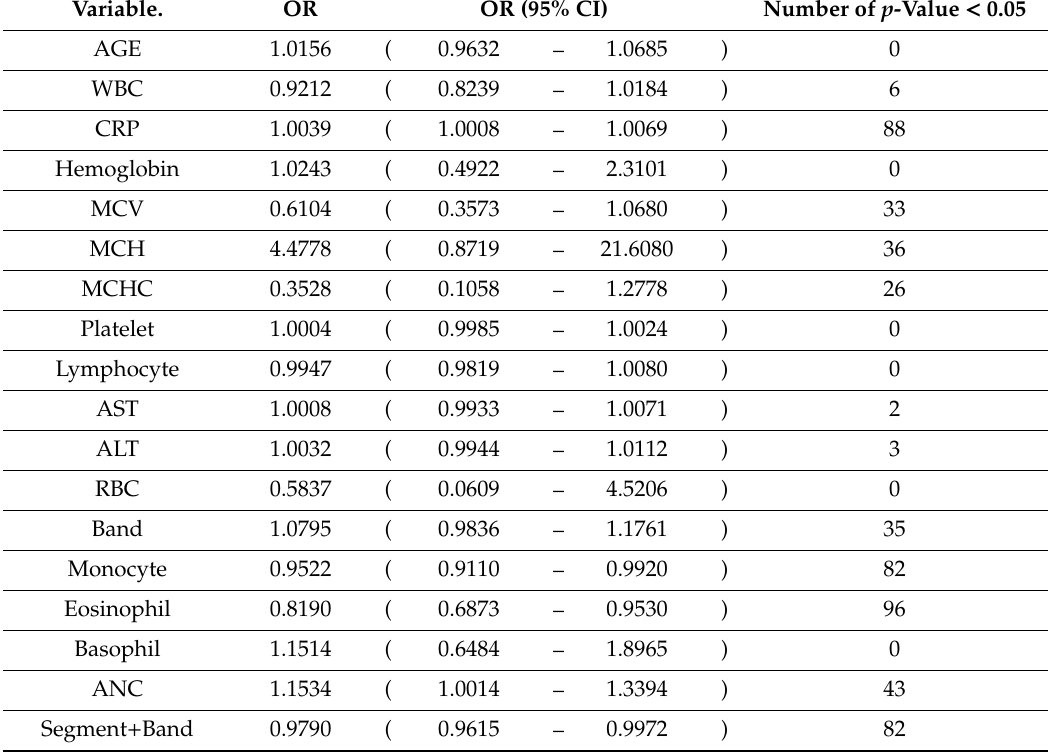
Table 3. The odds ratio of each variable and its 95%CI after repeating univariate logistic regression 100 times.